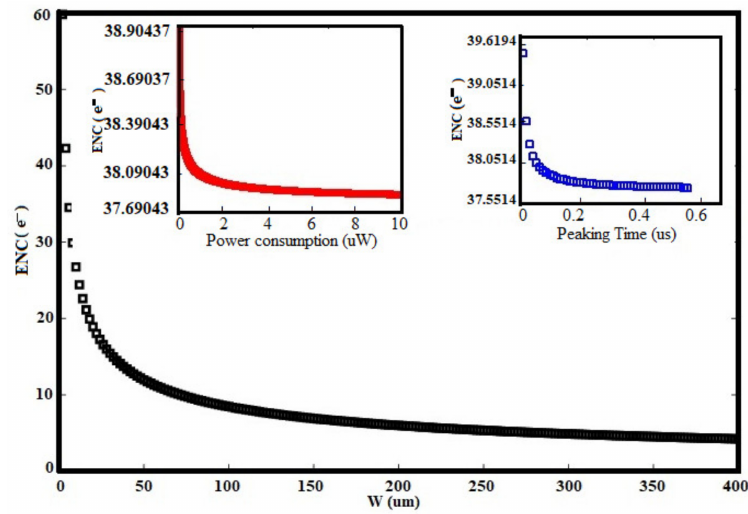
Figure 11. Equivalent Noise Charge (ENC) as a function of